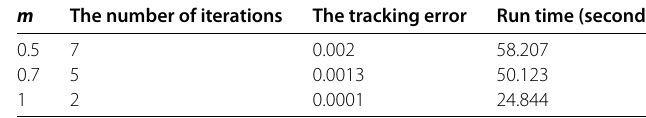
Table 1 The iteration number and the tracking error and the running time